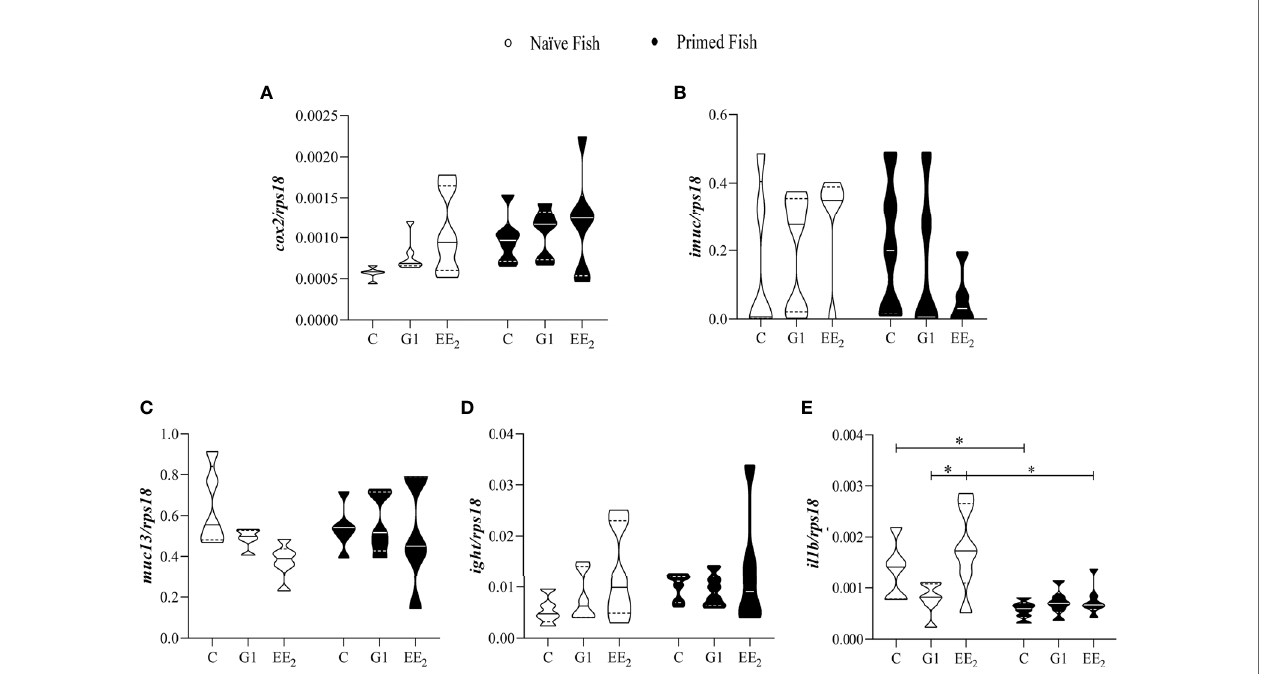
FIGURE 5 | The relative immune gene expression in the gut of gilthead seabream in response to the exposure in either G1 or EE2 under naive or immune primed condition minimally change. The fi sh had been orally treated with G1 or EE2 (5 m g/g food) for 43 days and either primed with KLH or not (naive) on the previous day. Gene expression levels (A) cyclooxygenase-2; (B) intestinal mucin; (C) mucin-13; (D) immunoglobulin T heavy chain; (E) interleukin-1beta are related to the expression of the 40S ribosomal protein subunit 18 (rps18). The violin graphs visualize quantitative and qualitative attributes of the samples comprised in each group. The mean is represented by the central solid line on each plot (n=6). Asterisks denote statistically signi fi cant differences between the groups.